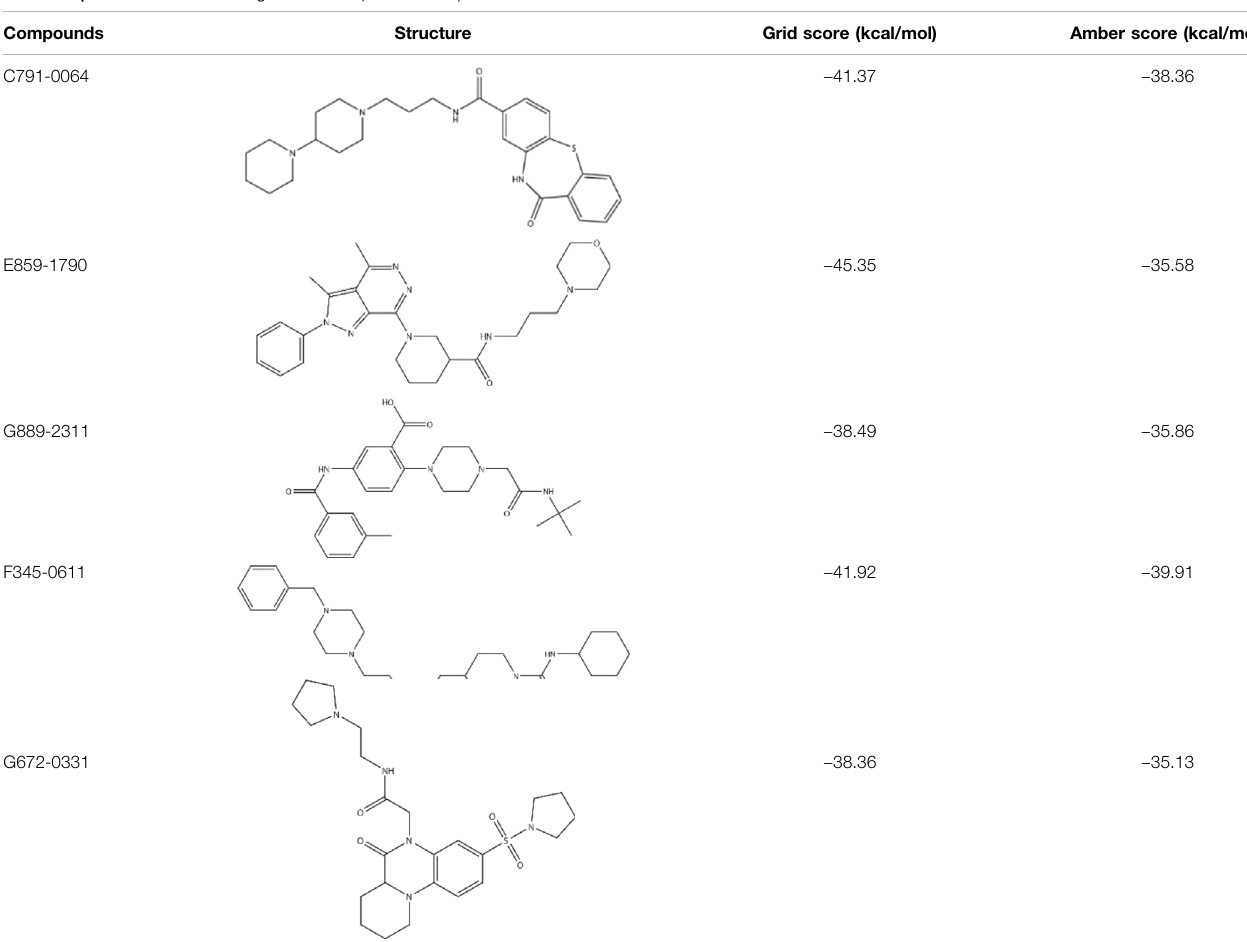
TABLE 1 | Structures and docking scores of representative putative RAD52